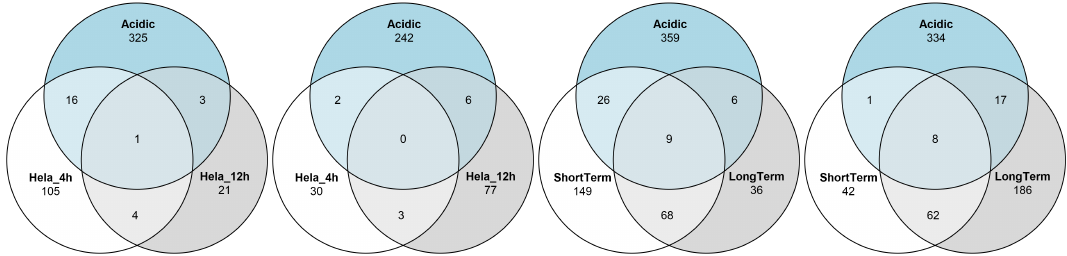
Figure 4. Comparative analysis between expressional profiles of 16M grown in a “pure” acidic environment versus the intracellular niche of its host. ( A ) Genes found to be downregulated in an in cellulo HeLa cell model. ( B ) Genes found to be upregulated in an in cellulo HeLa cell model. ( C ) Genes found to be downregulated in an in vivo goat supramammary lymph node model. ( D ) Genes found to be upregulated in an in vivo goat supramammary lymph node